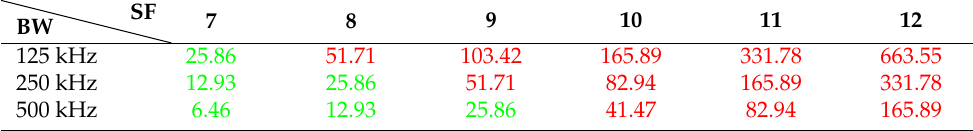
Table 4. Transmission time in ms of the optimized packet, in dependence of BW and